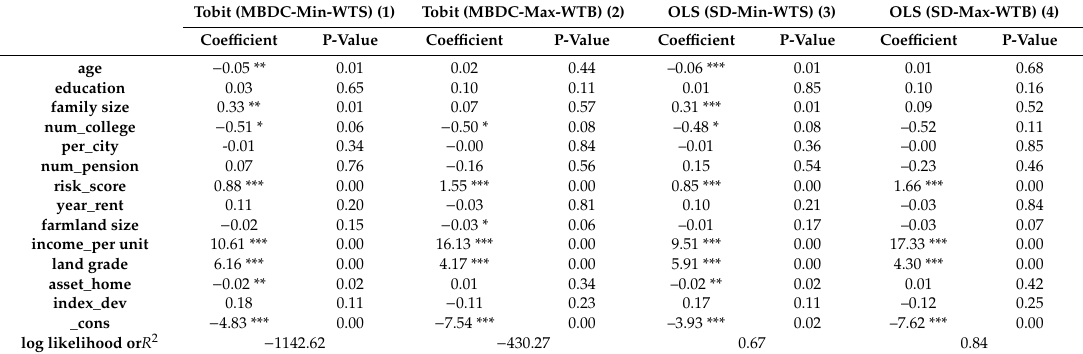
Table 5. Analysis of influential factors of potential transactions of farmers’ LCRs. OLS, Ordinary Least